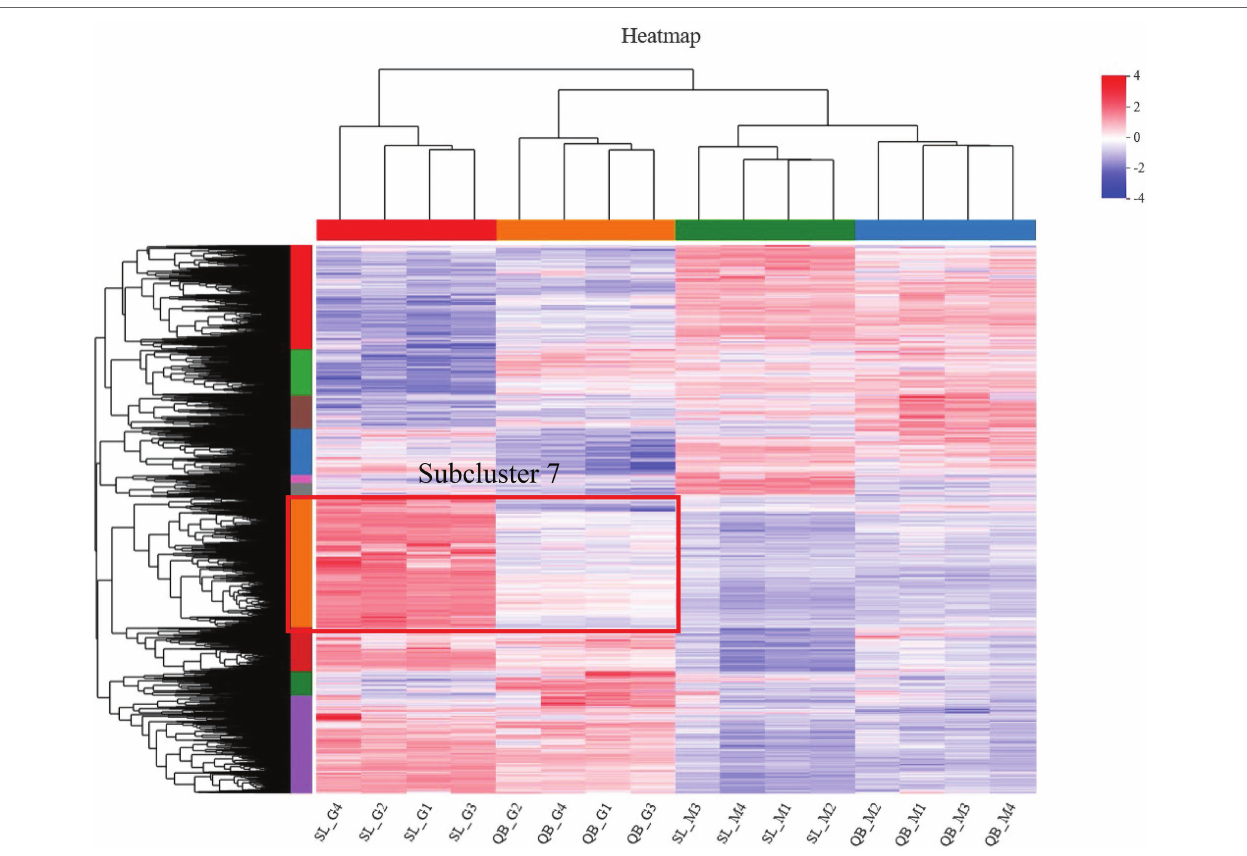
FIGURE 7 | Cluster analysis of all-germination-genes set in two stages at two sites. Each column represents a sample and each row represents a gene. The color indicates the expression value of the gene after normalization in each sample. Red means the gene is highly expressed, blue means the gene is lowly expressed, and the number next to the color bar on the top right indicates the specific trend. The tree diagram of gene cluster and the module diagram of subcluster are shown on the left side, and the closer the two gene branches are, the closer their expression levels are. The upper part is the tree diagram of sample cluster, and the lower part is the name of the samples, and the closer the two sample branches are, the closer the expression patterns of all genes in these two samples are, that is, the closer the variation trends of gene expression levels